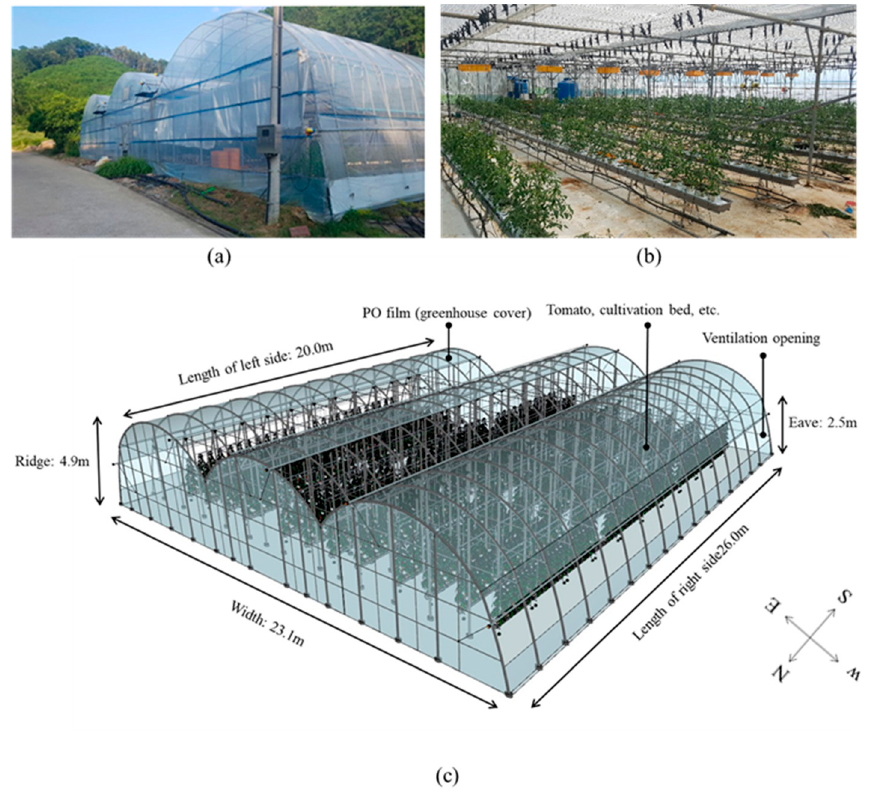
Figure 2. Experimental greenhouse in Andong University in Korea: ( a ) outside the greenhouse, ( b ) inside the greenhouse, and ( c ) three-dimensional configuration (latitude: 36°54 ′ N, longitude: 128°80 ′ E).